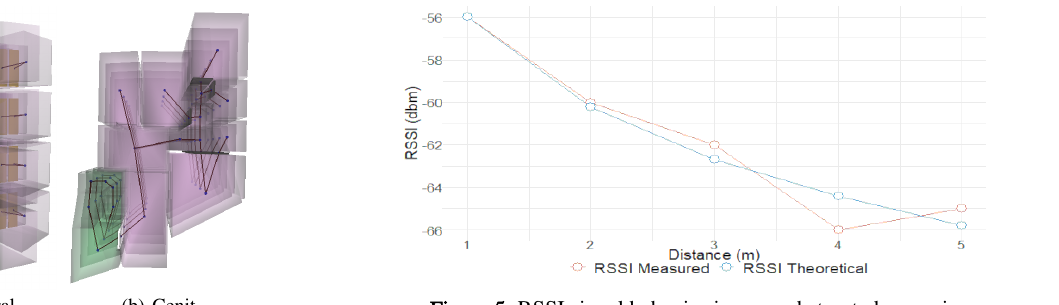
Figure 5. RSSI signal behavior in an unobstructed scenario